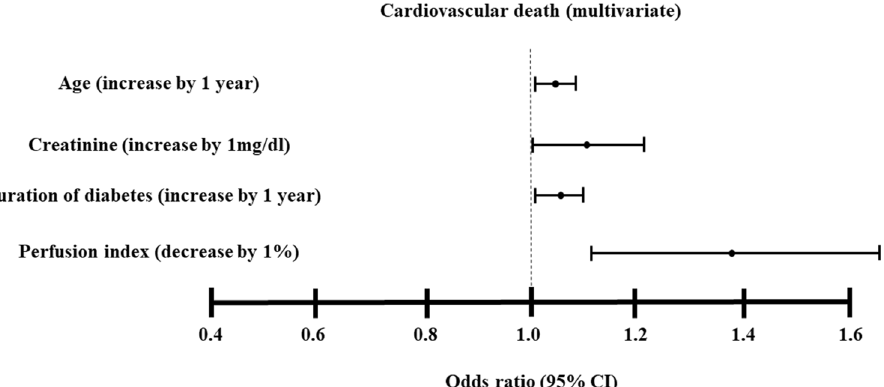
Figure 1. Predictors of cardiovascular death (multivariate analyses). The multivariate Cox proportional hazards regression models were done the following variables: sex, age, duration of diabetes, body mass index, systolic blood pressure, heart rate, hemoglobin A1c, total cholesterol, creatinine, smoking status, anti-platelet therapies, renin-angiotensin system inhibitor, glucagon-like peptide-1 agonists, sodium-glucose cotransporter 2 inhibitor and statin (model 2). Variables that remained significantly associated with cardiovascular death are presented.